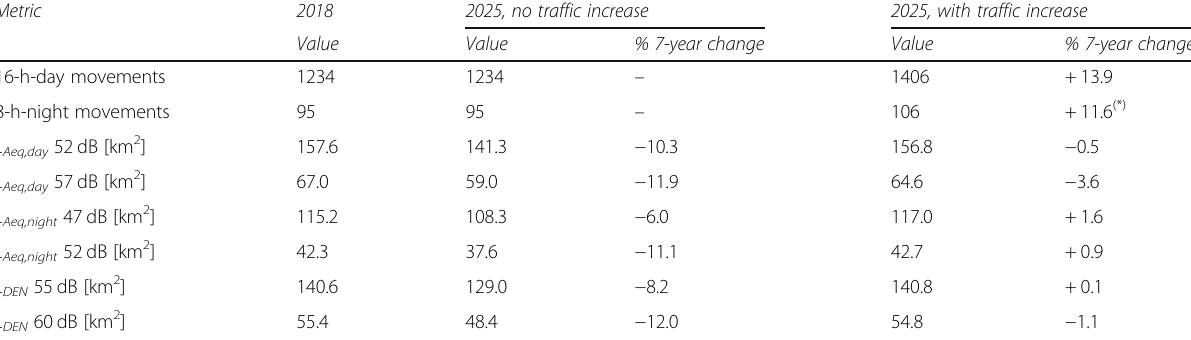
Table 4 Air traffic and noise contour areas at Frankfurt Airport in 2018 and 2025, considering or not traffic increase